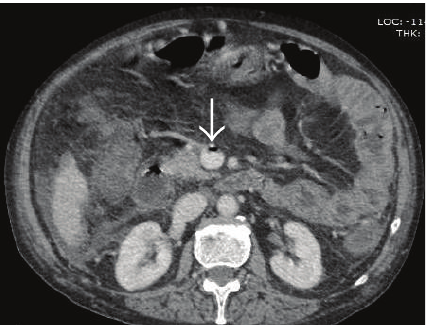
Figure51:AxialNCCTimageshowingsubmucosalbowelwallhem- orrhage appearing as linear hyperdense rim (solid arrows). Small bowel dilatation (asterisk) and pneumatosis intestinalis (interrupted arrow) can also be seen.